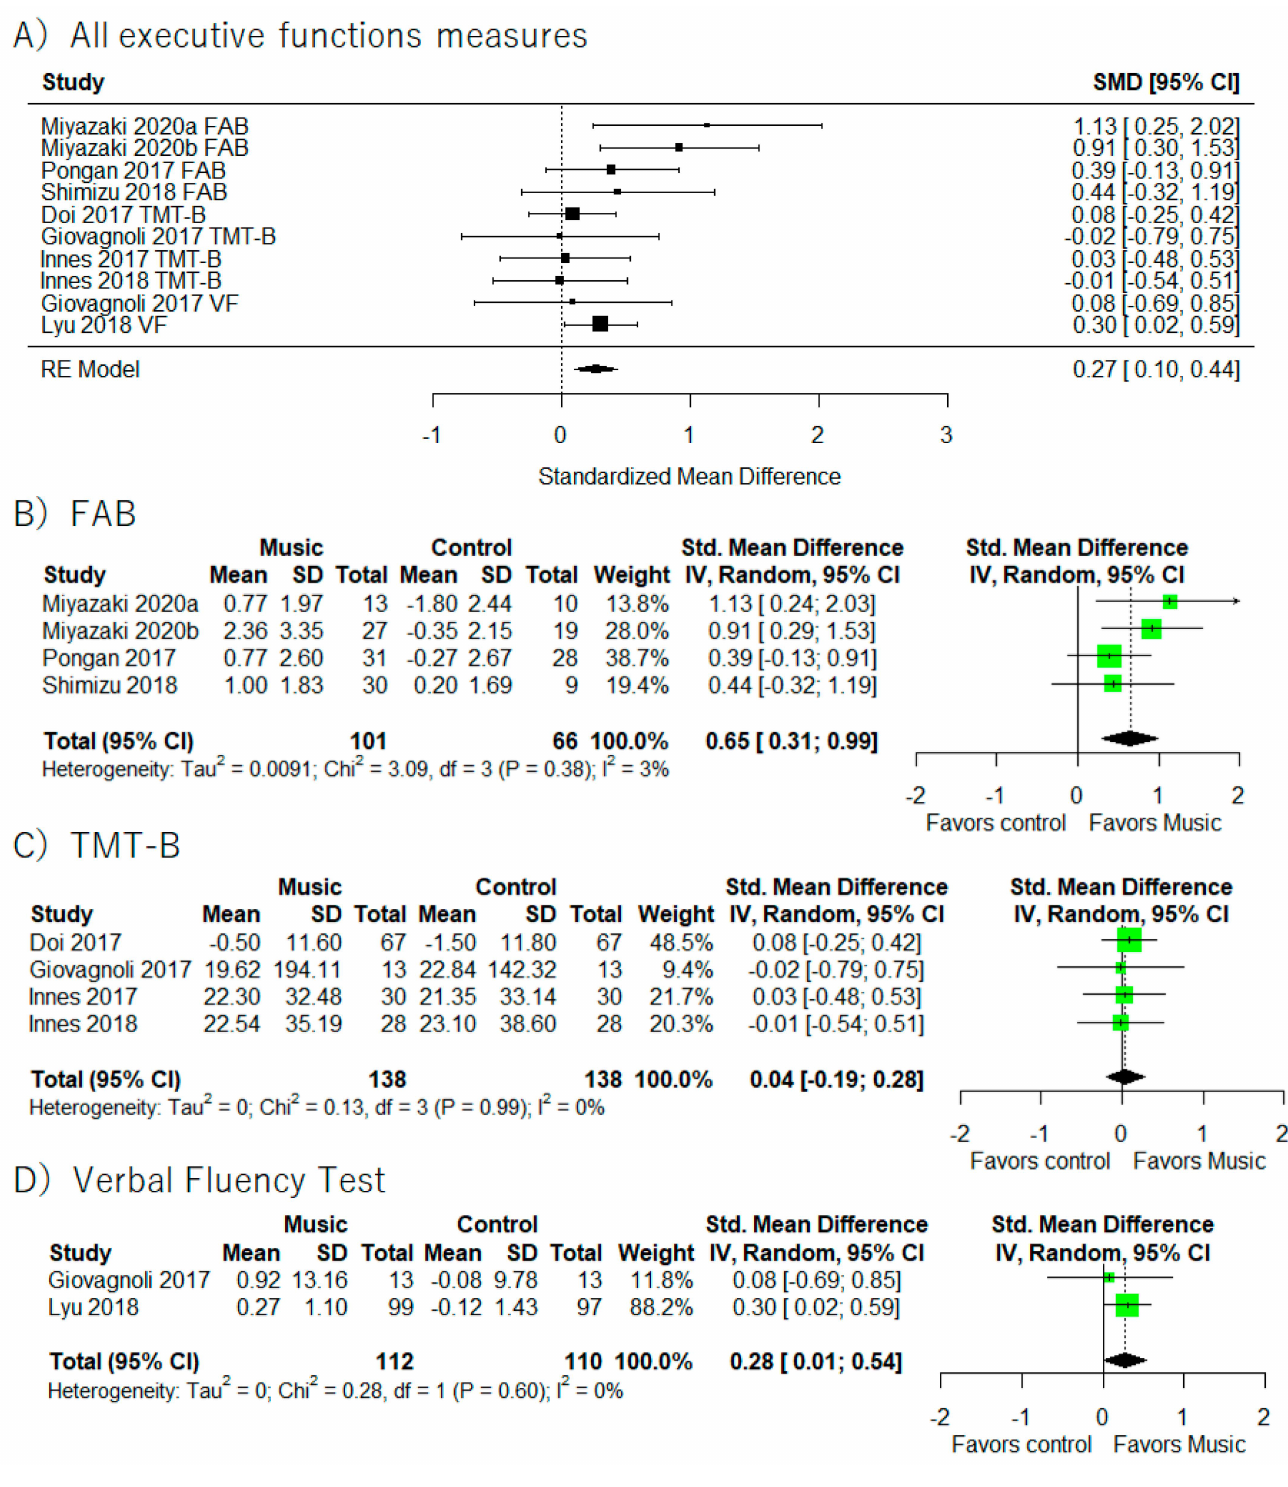
Figure 7. Trial level data, effect estimates, and forest plot for the effects of music-based intervention on all executive functions’ measures ( A ), TMT-B ( B ), FAB ( C ), and Verbal Fluency Test ( D ). The area of green square is proportional to the study’s weight in the